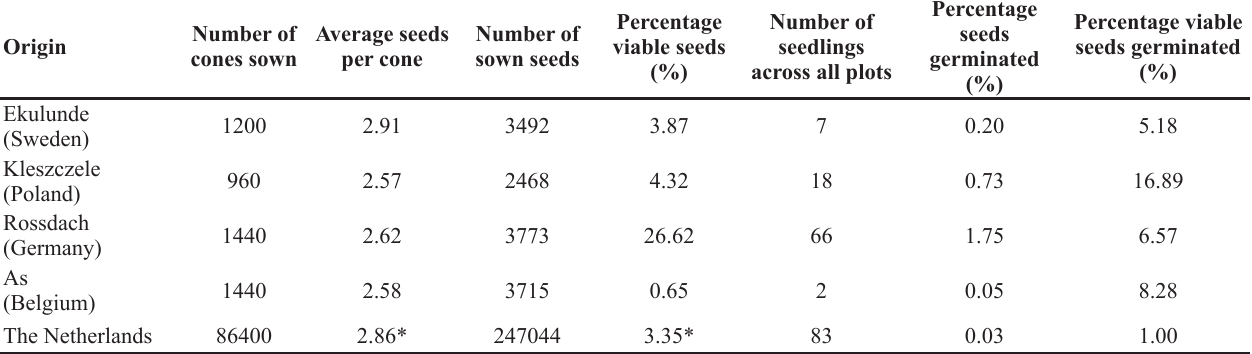
Table 1 – Information on the seeds used in the experiment. The number of sown seeds, their viability and the percentage of germinated seeds per origin. *These data were estimated based on the Dutch populations in Gruwez et al.